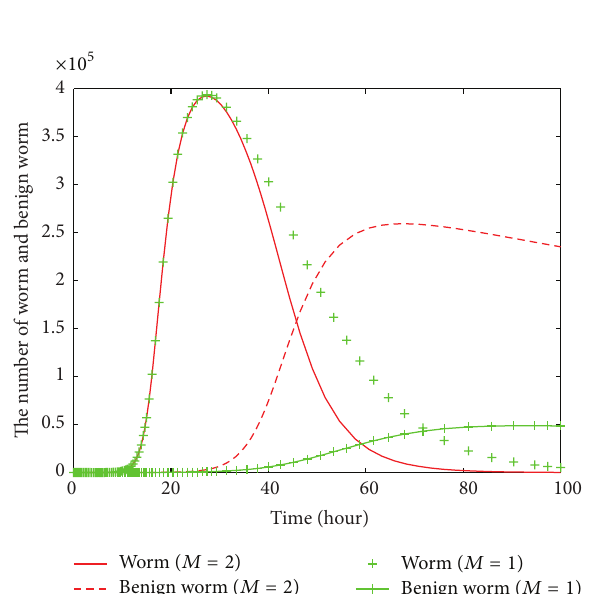
Figure 19: Comparison of different 𝑇